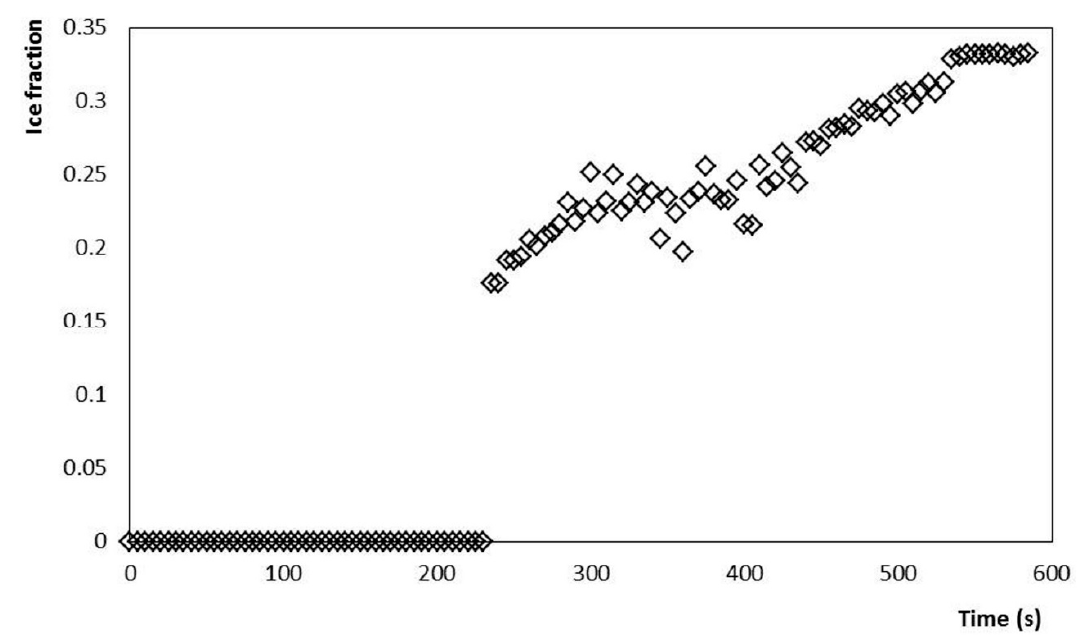
Figure 5. Ice fraction increase during crystallization of the mixture up to − 5 °C at a stirring rate of 200 rpm (3.33 s − 1 ).